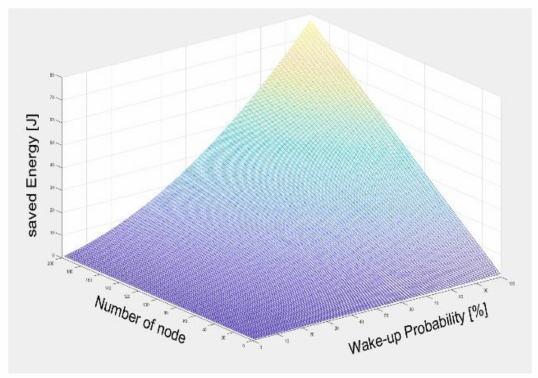
Figure 15. Comparison of node energy consumption for each communication